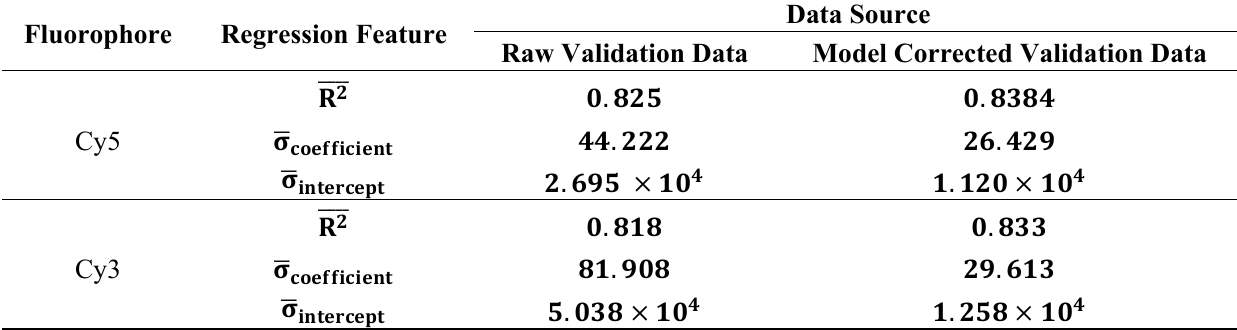
Table 4. Comparison of regression features of linear fit of ln ( I ) vs. V PMT for raw validation data and model corrected validation data for Cy5 and Cy3. Displayed are the mean R 2 as well as the mean σ for both parameters of the linear fit for both cyanine dyes for uncorrected and corrected validation